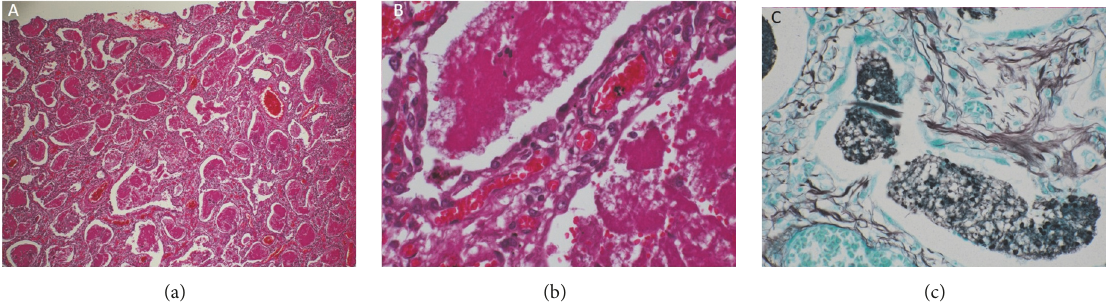
Figure 3: (a) A photomicrograph (original magnification, × 40; hematoxylin-eosin staining) of a section of lung tissue. The section showed homogeneous septal thickening and intra-alveolar eosinophilic exudate. (b) A high-power photomicrograph (original magnification, × 400; hematoxylin-eosin staining) of a section of lung tissue showed thickening of the alveolar septa due to both chronic inflammation and a small amount of collagen. The intra-alveolar spaces were filled with foamy acellular eosinophilic exudate. (c) A high-power photomicrograph (original magnification, × 400; Grocott's methenamine silver staining) of a section of lung tissue. Numerous cysts of Pneumocystis jirovecii were observed within the intra-alveolar foamy exudate.